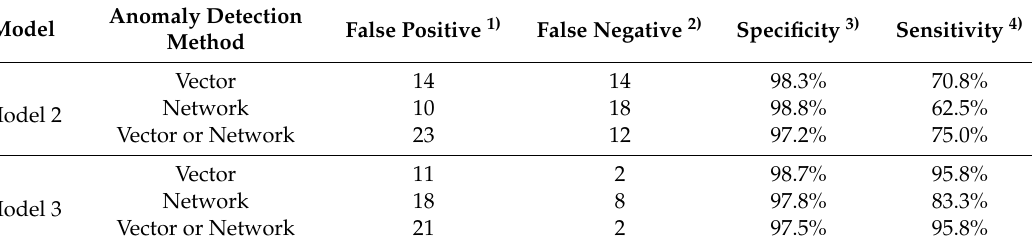
Table 7. Anomaly detection performance by method.